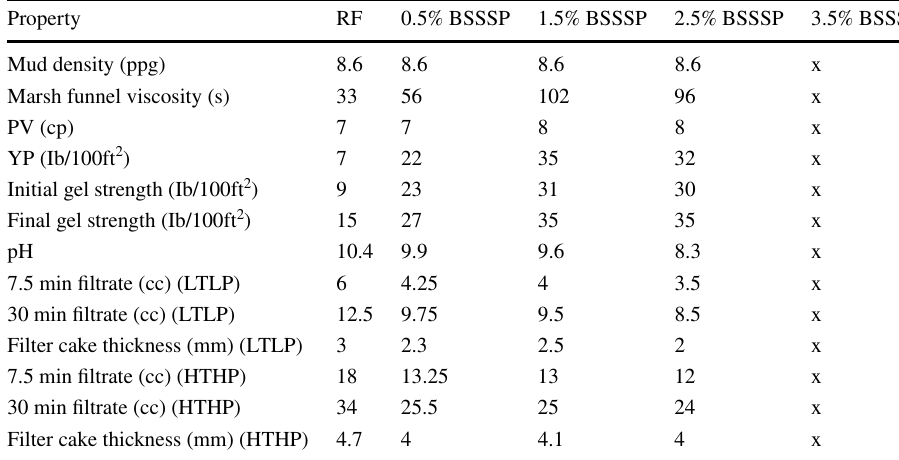
Table 1 The findings of the reference fluid and four concentrations of BSSSP (fresh conditions)